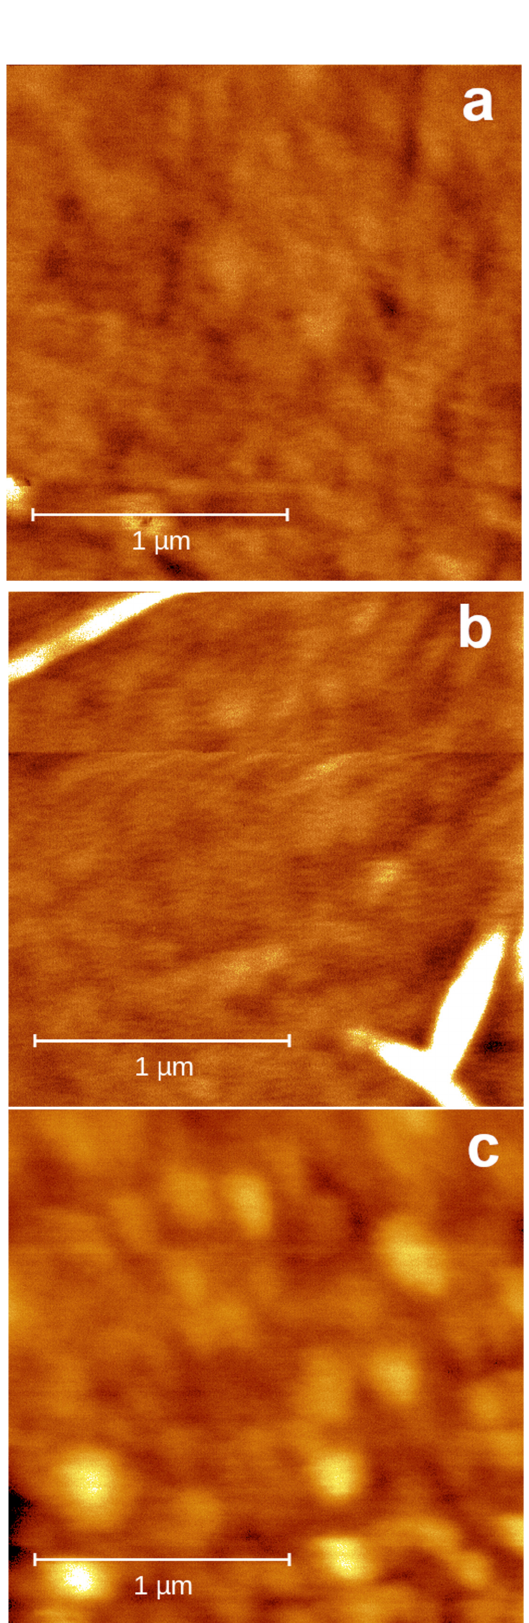
Figure 2. ( a ) AFM images of the graphene surface before irradiation, ( b ) after irradiation with a charge state of Q = 6+ and ( c ) after irradiation with equilibrium charge state, both with the same 5 × 10 13 ions/cm 2 fluence. The images have the same false colour vertical scale range of 3 nm. Although AFM images do not show changes due to SHI irradiation, the presented results of the Raman spectroscopy measurements clearly show that monolayer graphene is sensitive to charge state effects when irradiated with a 23 MeV I beam. The charge state equilibration, i.e., the increase in the ion charge state from Q = 6+ to Q = 14+, results in an increase in the electronic stopping by 50% in graphene and by 30% in a-SiO 2 substrate. Usually, the electronic stopping of monolayer graphene is assumed to be one-third of the electronic stopping of graphite because the thickness of graphene is only 0.3 nm [32]. In our previous work, we showed that energy deposited in very thin graphite films can easily dissipate [12], and similar findings were reported in other works [10,11,35]. However, in